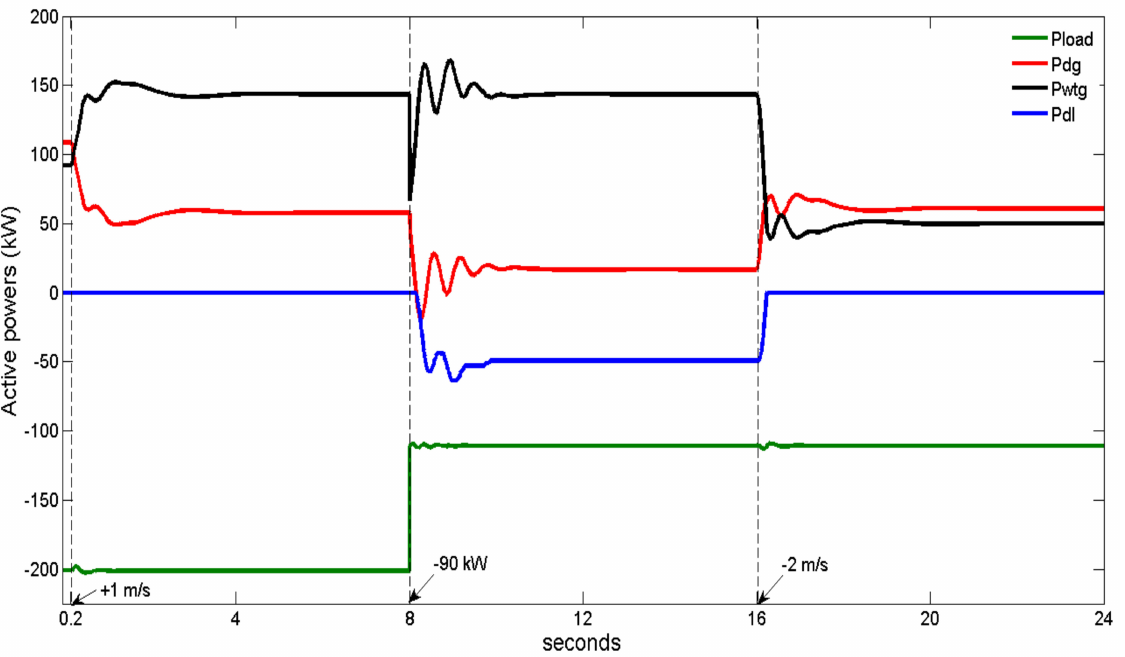
Figure 9. Generated (+)/consumed (-) active powers in the WDIM